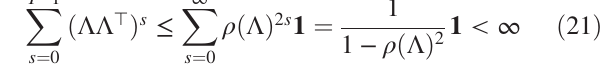
ffiffiffiffiffiffiffiffiffiffiffiffiffiffiffiffiffiffiffiffiffiffiffiffiffiffiffi